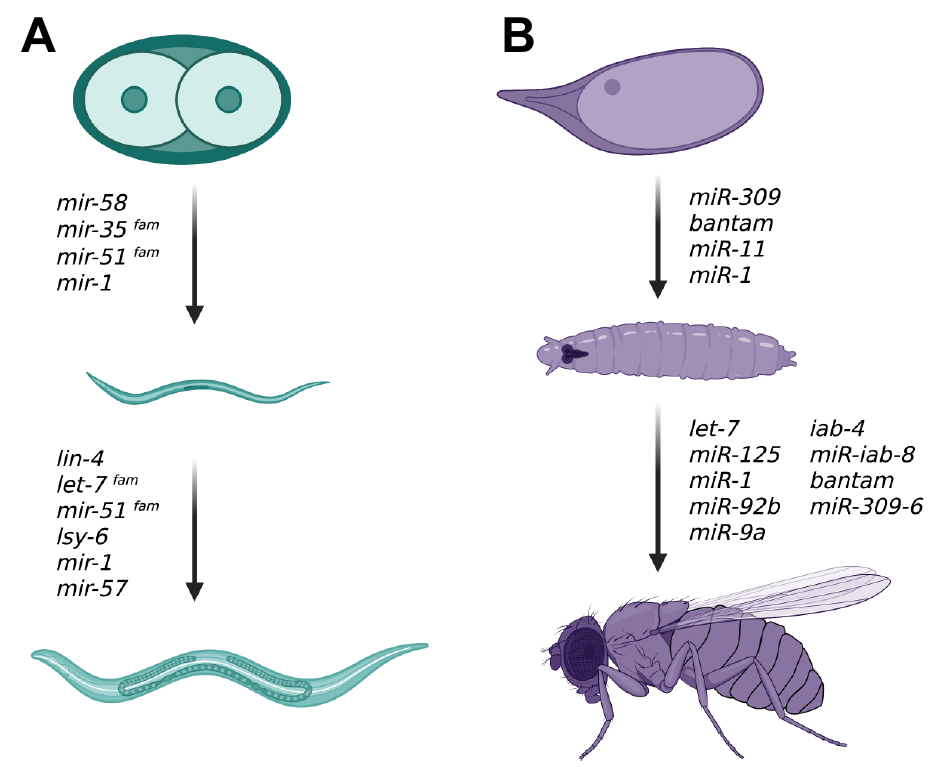
Figure 4. miRNAs involved in ( A ) C. elegans and ( B ) Drosophila development. Some of the many miRNAs that are required during both embryonic and larval development are listed for each invertebrate model organism.